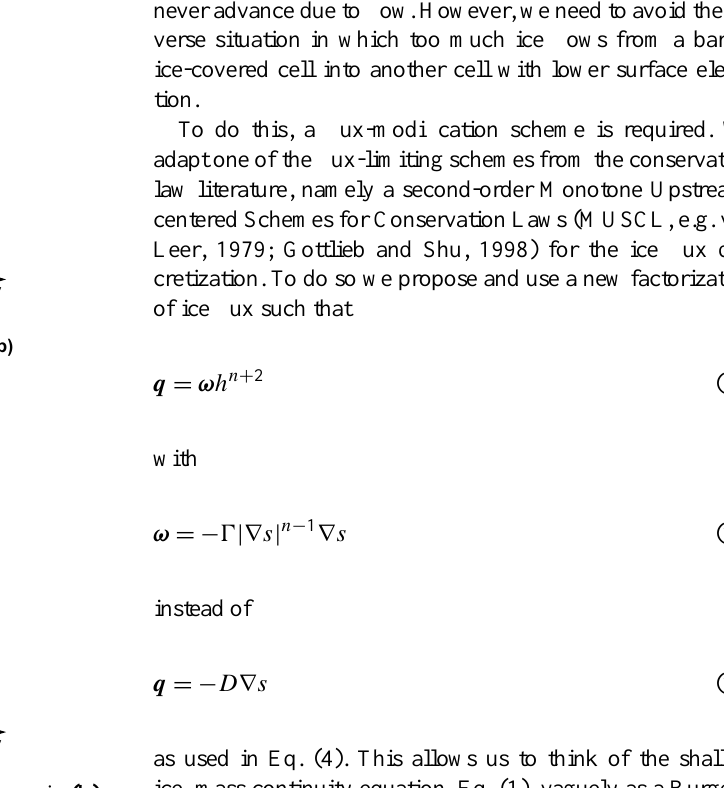
Fig. 2. The valley glacier case in (a) and the icefall case in (b) . Bedrock in grey and ice in light